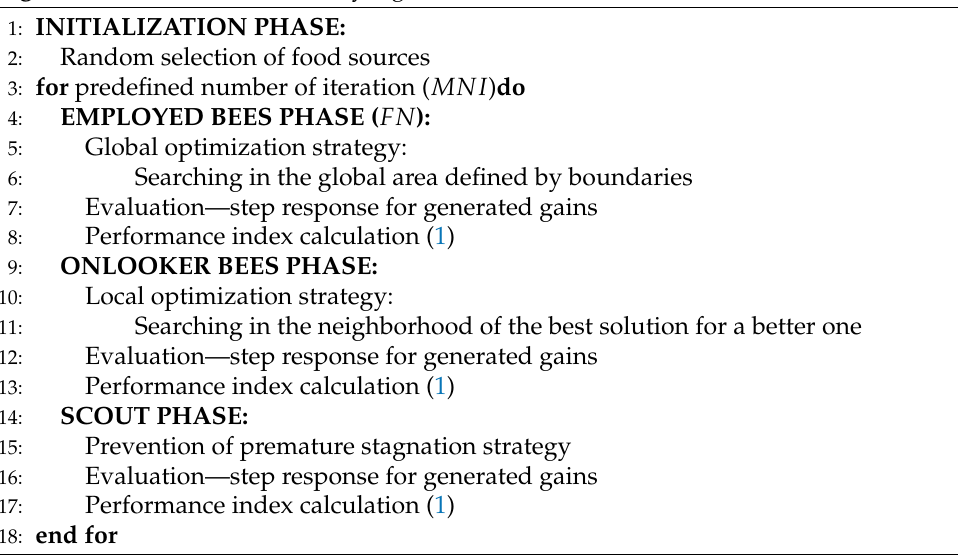
Algorithm 1 Artificial Bee Colony algorithm.